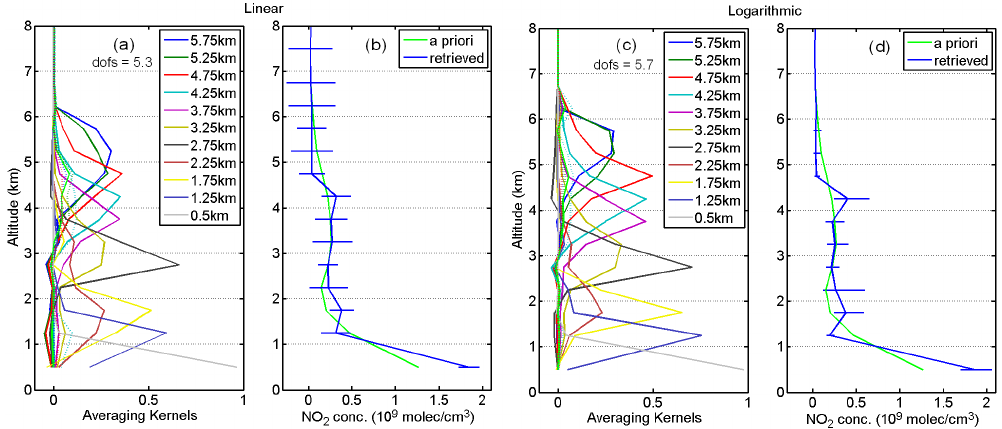
Fig. 11. Comparison of the NO 2 profile retrieval using linear (left) and logarithmic (right) weighting functions for the sounding of the as0831 flight (8 April 2008). The two panels show the respective averaging kernels and retrieved profiles. The results are very close, contrary to the aerosol extinction retrieval.